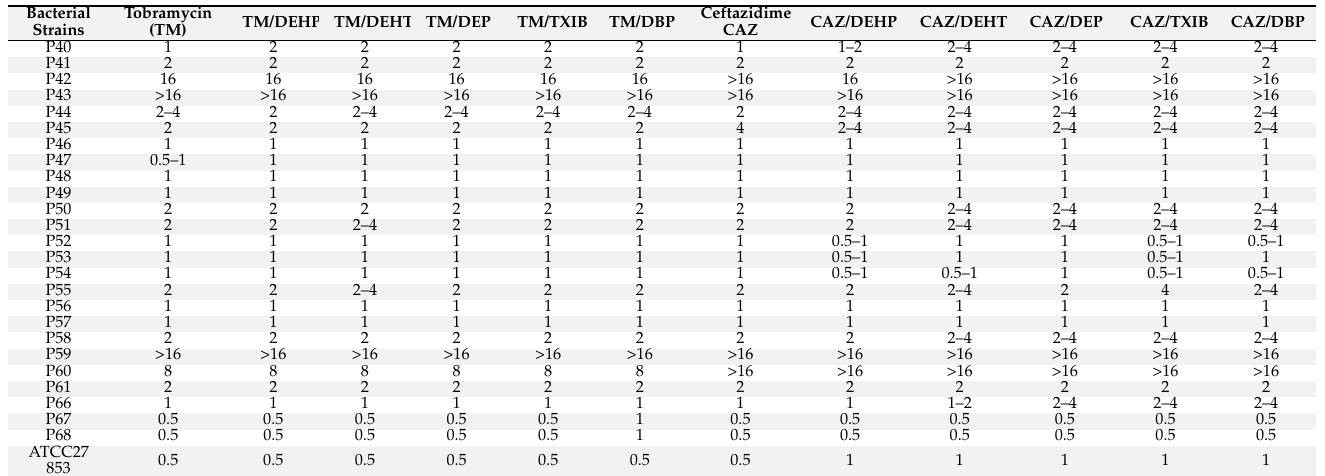
Table 1. Effects of DEHP, DEHT, DEP, TXIB, and DBP (10 − 3 M) on P. aeruginosa clinical